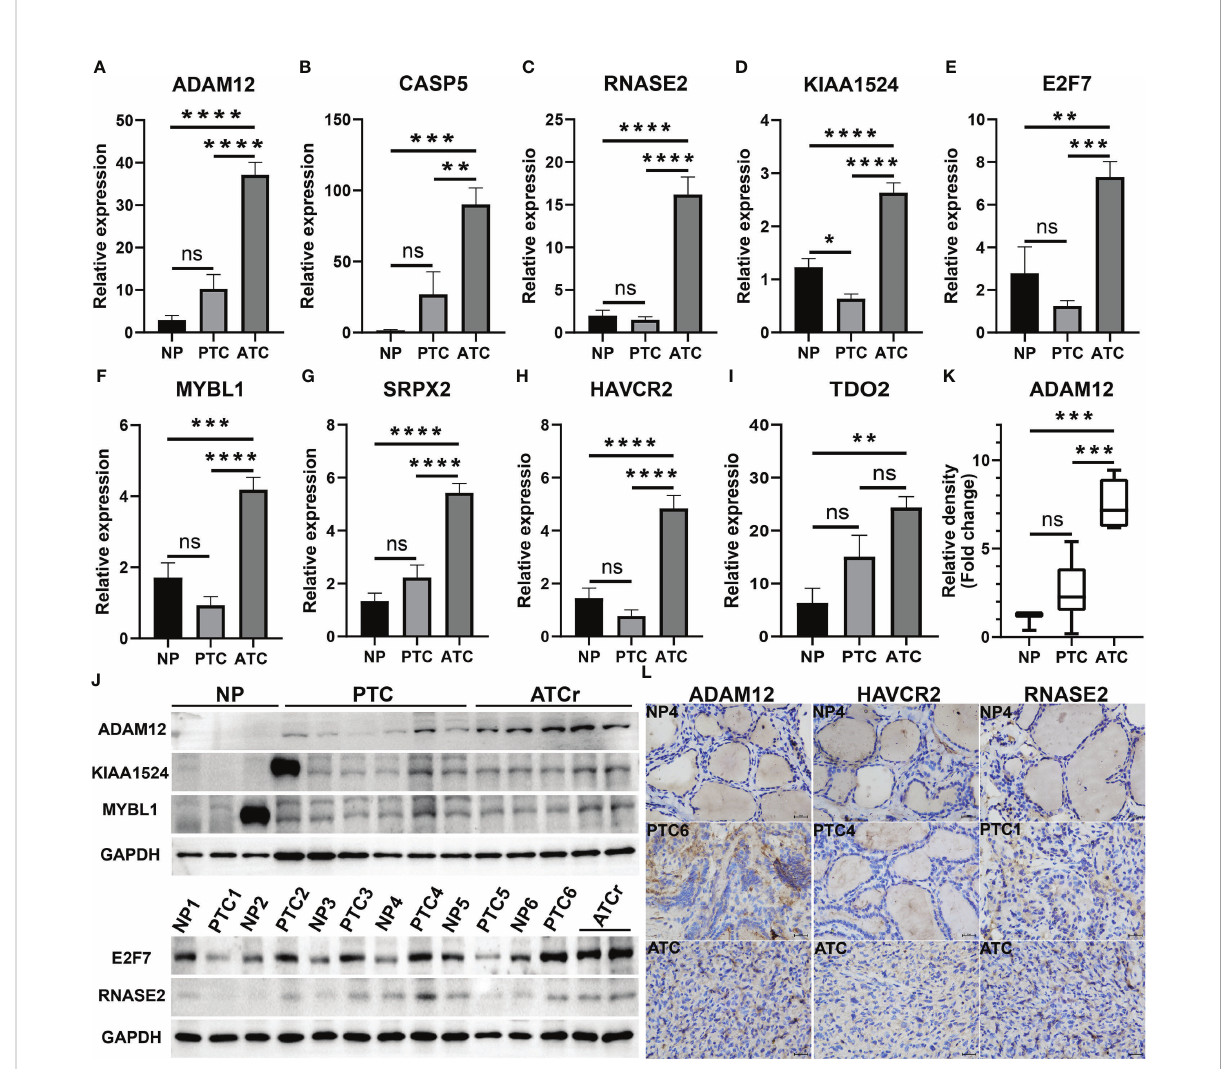
FIGURE 5 Validation of novel ATC-speci fi c key genes. (A – I) The mRNA expression levels of nine key genes in one ATC sample compared to PTC and paired normal thyroid samples evaluated using qRT-PCR. Among them, E2F7 and MYBL1 are TFs, HAVCR2 and TDO2 are ICGs. (J, K) Protein expression levels of top four driver genes in clinical samples detected by western blotting (WB) and the corresponding semi-quantitative analysis of ADAM12. (L) Representative immunohistochemistry (IHC) staining for ADAM12, HAVCR2, and RNASE2 expression in clinical samples ( X 400). **p < 0.01, ***p < 0.001, ****p < 0.0001. NP, PTC paired normal thyroid tissues; NP1-6, normal thyroid tissues from PTC patients numbered 1- 6; PTC1-6, PTC tissues from PTC patients numbered 1-6; ATCr, ATC tissues from one ATC patient; ns, no signi fi